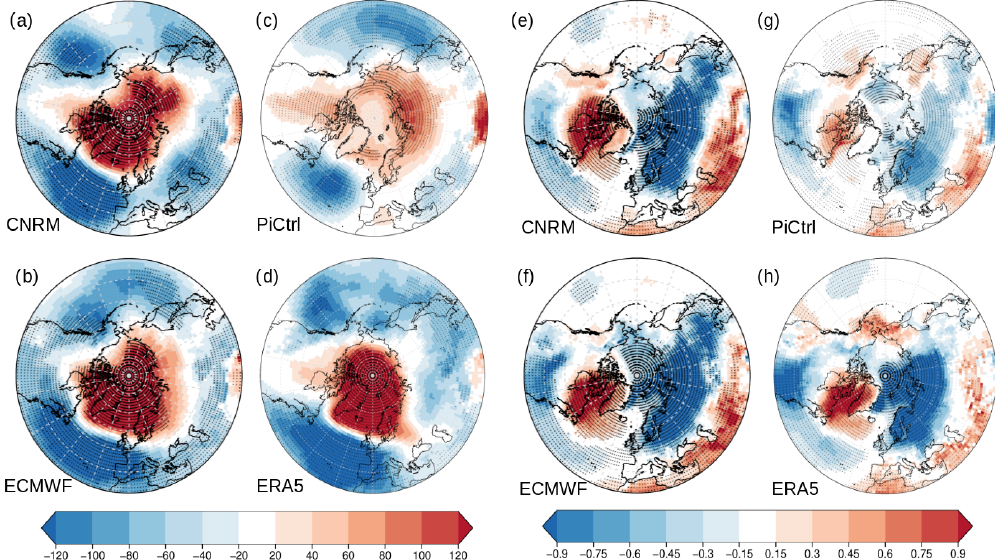
Figure 8. Same as Fig. 7 for NAO- initial